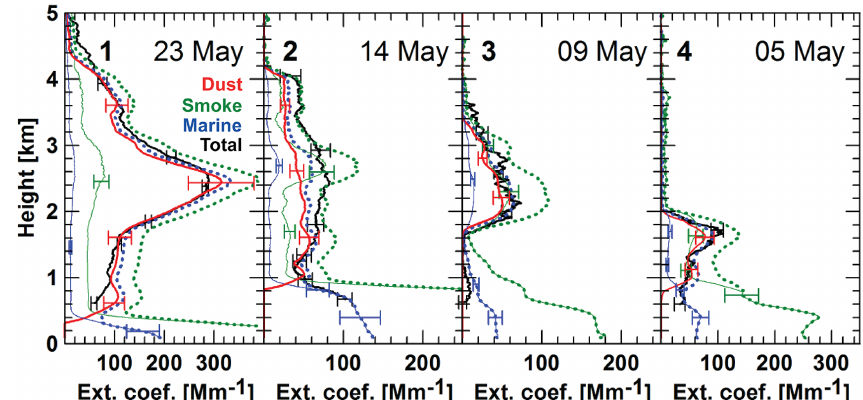
Figure 3. The Saharan aerosol layer as a function of distance from Africa (see Fig. 1, cases 1–4). Shown are the 532nm particle extinction coefficients measured with Raman lidar (black curves) on 5–6 May, 23:40–00:35UTC (case 4), 9 May, 23:15–24:00UTC (case 3), 14– 15 May, 23:45–00:20UTC (case 2), and 23 May 2013, 03:45–05:00UTC (case 1), and the extinction contributions by desert dust (red solid line) and marine (blue solid line, lidar ratio of 20sr) or smoke and haze particles (green solid line, lidar ratio of 50sr). The sums of dust and non-dust extinction contributions are given as thick dotted lines. If the black extinction curve is close to the blue dotted line, the non-dust aerosol component is probably of maritime origin (cases 1, 3, 4). In the case that the black and green dotted lines match, the non-dust aerosol component is most likely of anthropogenic origin (upper part of case